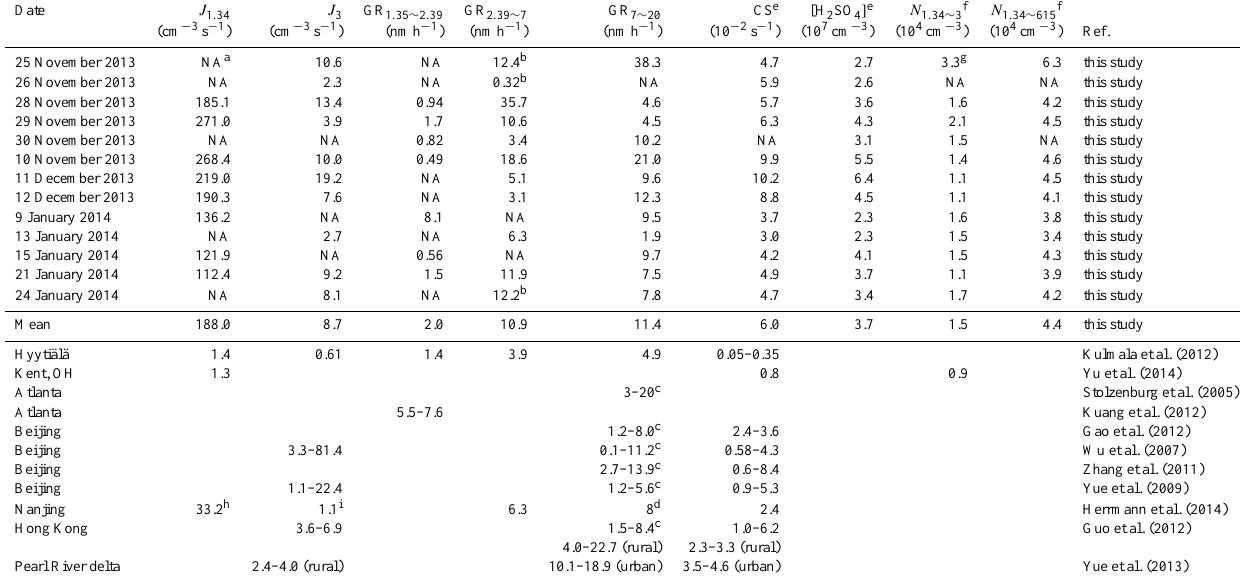
Table 1. Nucleation rate ( J 1 . 34 ), formation rate of 3nm particles ( J 3 ), particle growth rates (GR 1 . 35 ∼ 2 . 39 , GR 2 . 39 ∼ 7 , and GR 7 ∼ 20 ), con- densation sink (CS), sulfuric acid proxy ( [ H 2 SO 4 ] ), number concentrations of 1.34–3nm clusters/particles ( N 1 . 34 ∼ 3 ), and total number concentrations of particles ( N 1 . 34 ∼ 615 ), of each NPF event during this campaign.